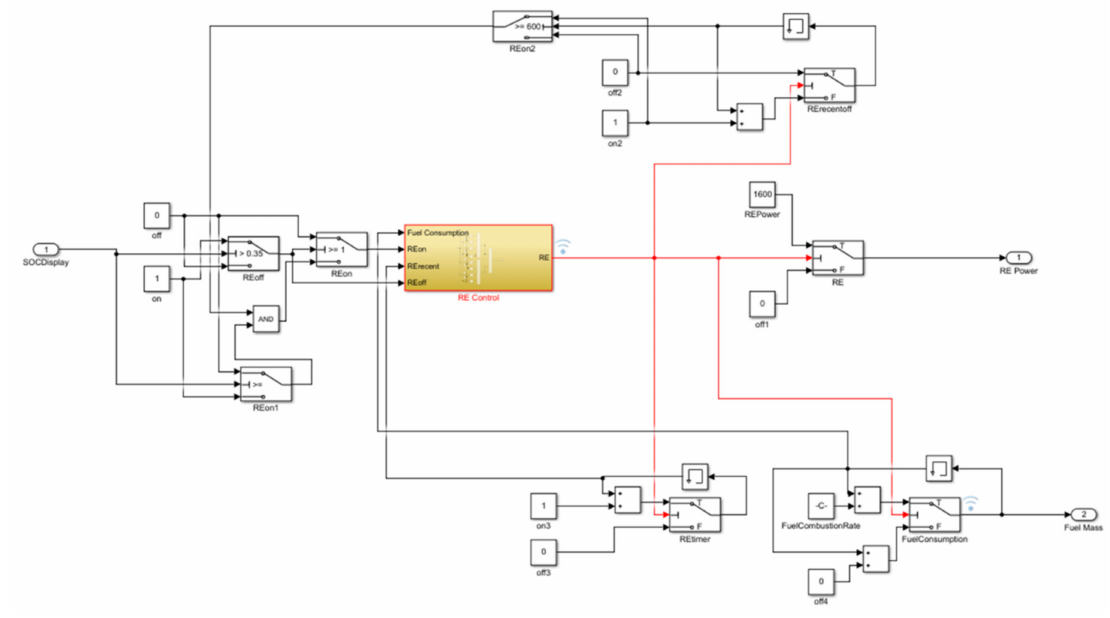
Figure 7. Range extender subsystem block model.